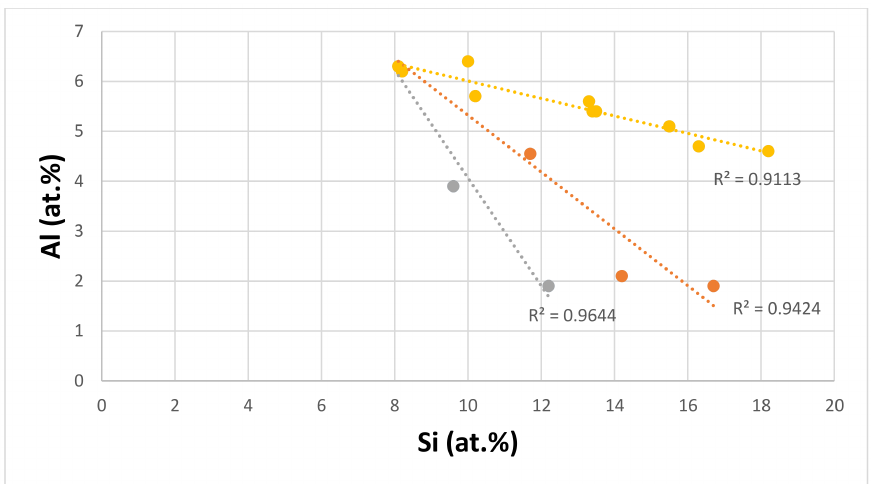
Figure 10. Al versus Si of eutectics with Nb ss and Nb 5 Si 3 in Nb-silicide based alloys, series a (R 2 = 0.9644) with alloying element additions of Al, Cr, Ge, Hf, Mo, Si, Sn, Ti, W, and Y; series b (R 2 = 0.9113) with alloying element additions of Al, Cr, Ge, Hf, Mo, Si, Sn, Ti, V, W, and Y; series c (R 2 = 0.9424) with alloying element additions of Al, Cr, Fe, Ge, Hf, Mo, Si, Sn, Ti, and W.